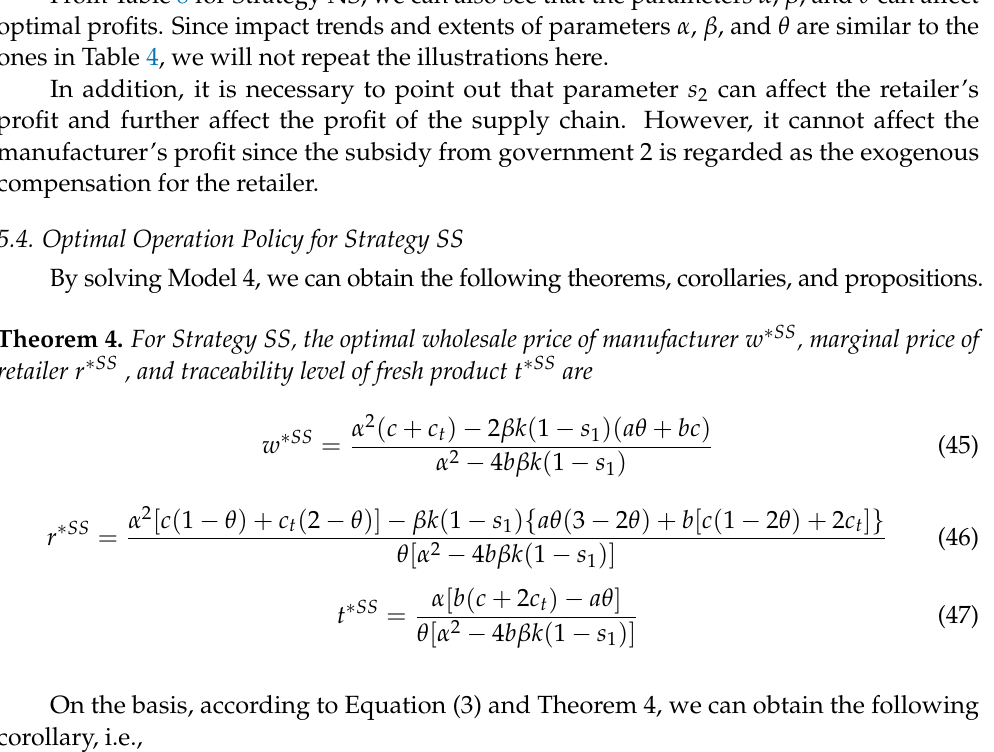
Table 8. The sensitivities of optimal profits to model parameters for Strategy NS. α β θ s 2 ↑ ↓ ↑ – π ∗ NS M ↓↑ ↓↑ ↑ ↑ π ∗ NS R ↓↑ ↓↑ ↑ π ∗ NS SC